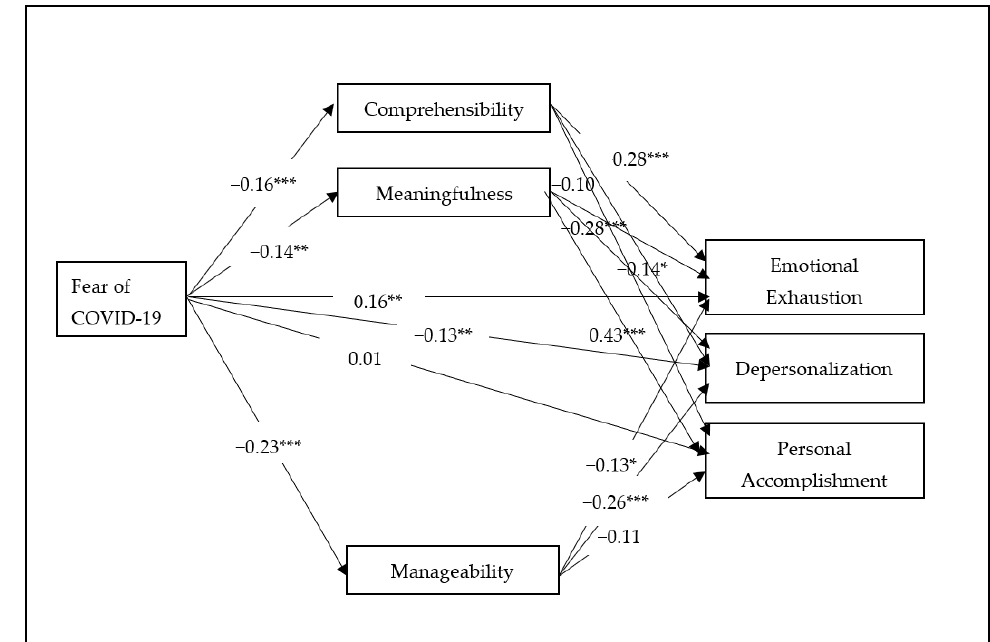
Figure 1. Structural equation model of the interrelationship between variables. Note. Regression